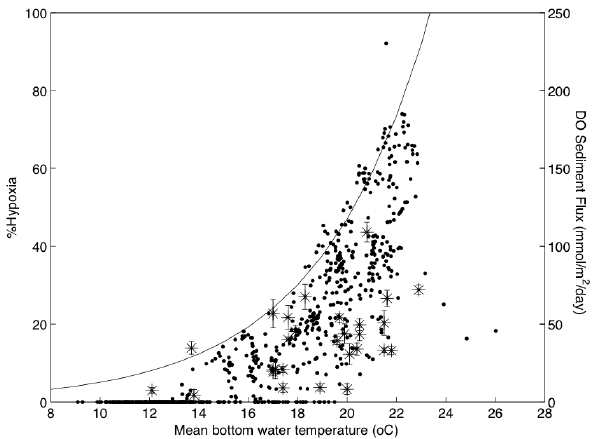
Fig. 10. Comparison of experimental rates of sediment oxygen de- mand (*) and area percentage hypoxia (DO < 4mgL − 1 ) ( • ) against temperature. The solid line represents an Arrhenius temperature function of the form: F max θ (T − 20 )